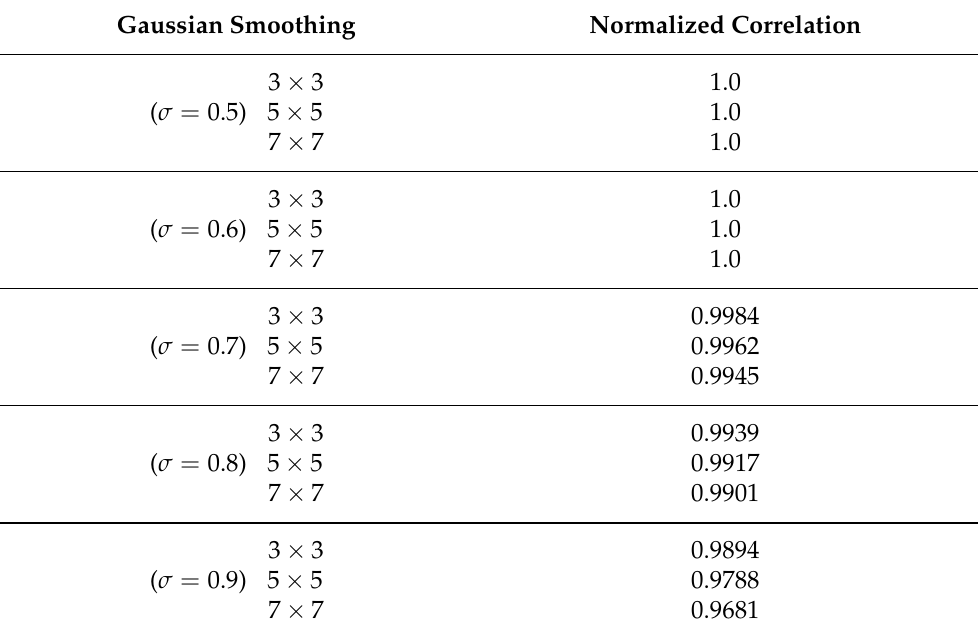
Table 4. Robustness evaluation measured in terms of normalized correlation after Gaussian smooth- ing for Mandrill image.